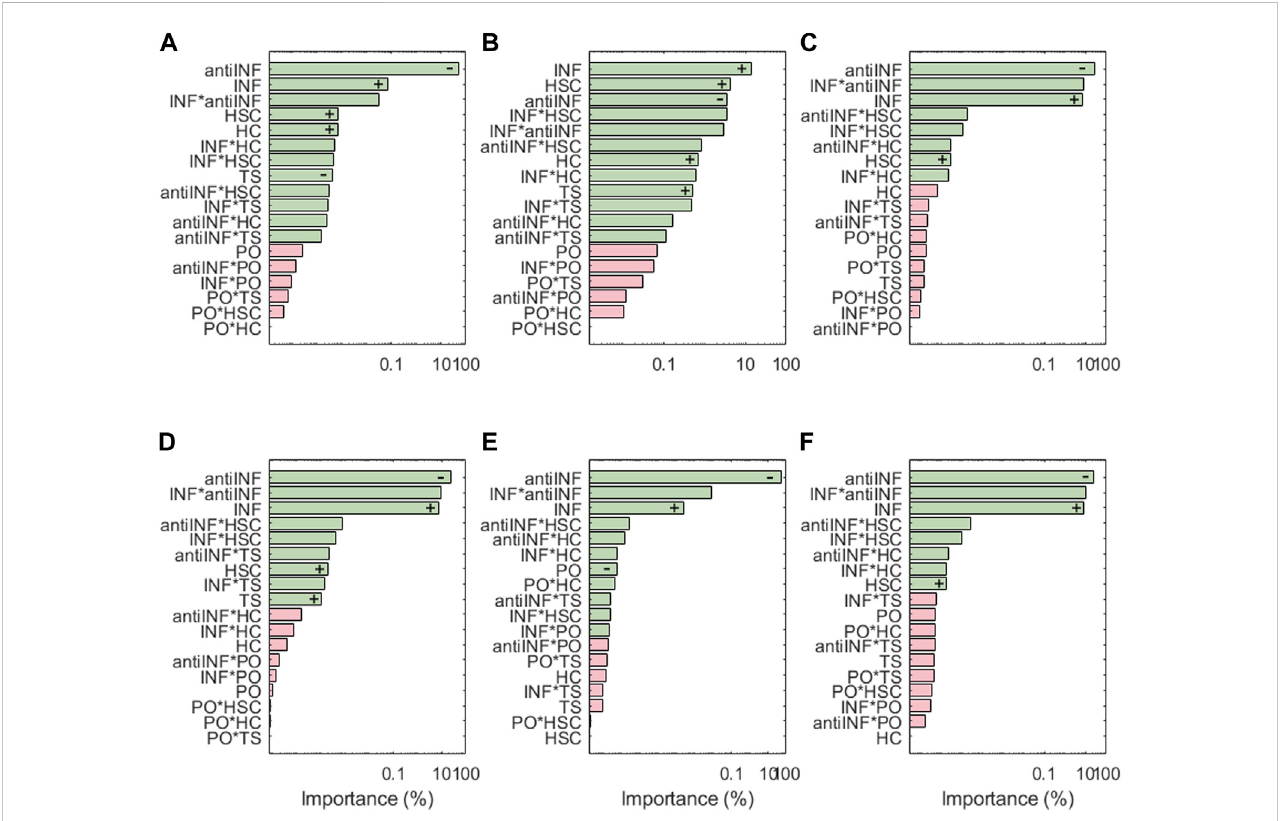
FIGURE 6 Pareto charts of (A) ADAMT4, (B) ADAMT5, (C) MMP1, (D) MMP13, (E) MMP14 and (F) MMP3. Signi fi cant interactions are colored in green ( α =0.05), non- signi fi cant in pink. +: positive in fl uence; − : negative in fl